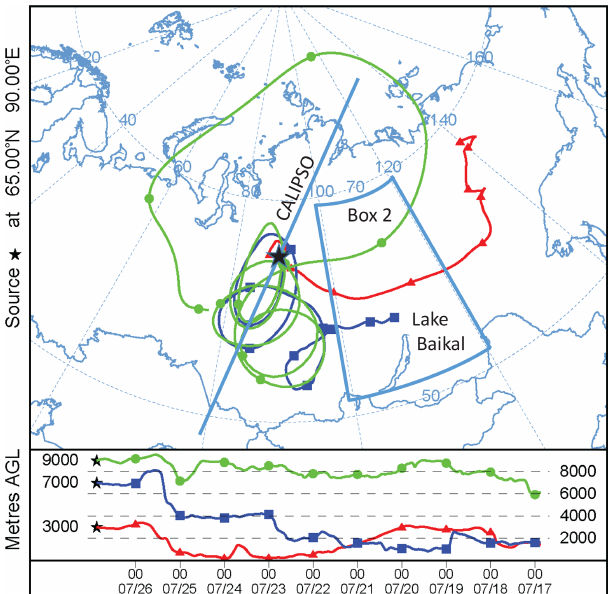
Figure 5. HYSPLIT 10d backward trajectories (HYSPLIT, 2021; Stein et al., 2015; Rolph et al., 2017) for 26 July 2019, at 21:00UTC, arriving at 3000m (red), 7000m (blue), and 9000m height (green) above the location indicated by a star (65 ◦ N, 90 ◦ E). The CALIPSO flight track of the measurements shown in Fig. 4 is indicated by a straight line, which is west (downwind) of a large fire area (box 2 in Fig.